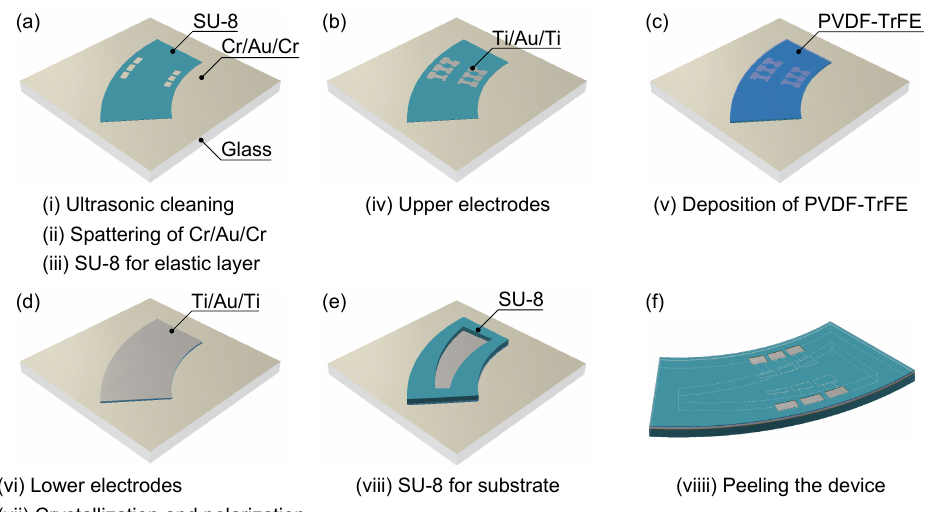
Figure 3. Technique of fabricating a miniaturized artificial cochlear sensory epithelium for implanta- tion in guinea pigs. ( a ) A glass substrate is ultrasonically cleaned using isopropanol. Cr/Au/Cr as a sacrificial layer is sputtered on the glass substrate. On the surface of Cr, an elastic layer of SU-8 is deposited. ( b ) Using the lift-off method, the Au for the upper electrodes is deposited on SU-8 with Ti as an adhesion layer. ( c ) On the surface of the SU-8 and Au electrodes, a PVDF-TrFE film is deposited. ( d ) Using the lift-off method, the Au for the lower electrodes is deposited on PVDF-TrFE with Ti as an adhesion layer. ( e ) SU-8 is deposited on the lower electrodes of the substrate with a curved–trapezoidal aperture. ( f ) A Cr etchant is used to peel the miniaturized artificial cochlear sensory epithelium from the glass